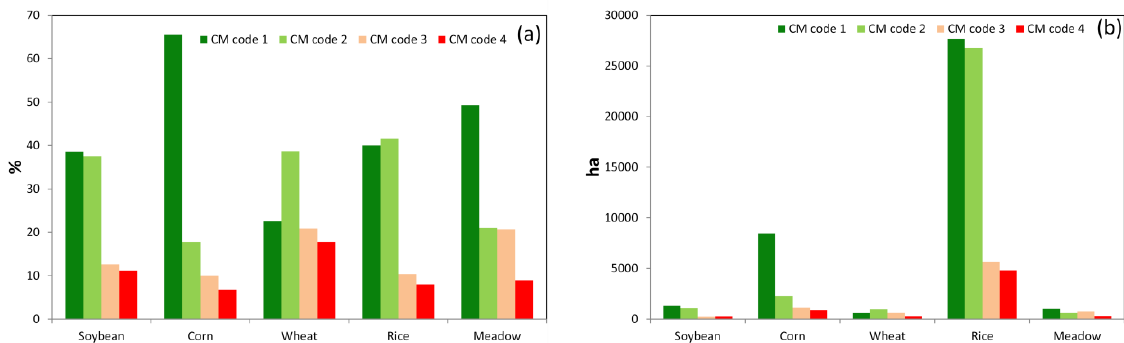
Figure 9. ( a ) CM code for each crops analyzed (%); ( b ) CM code for each crops analyzed in terms of surface (ha). Code meaning is reported in Table 9.